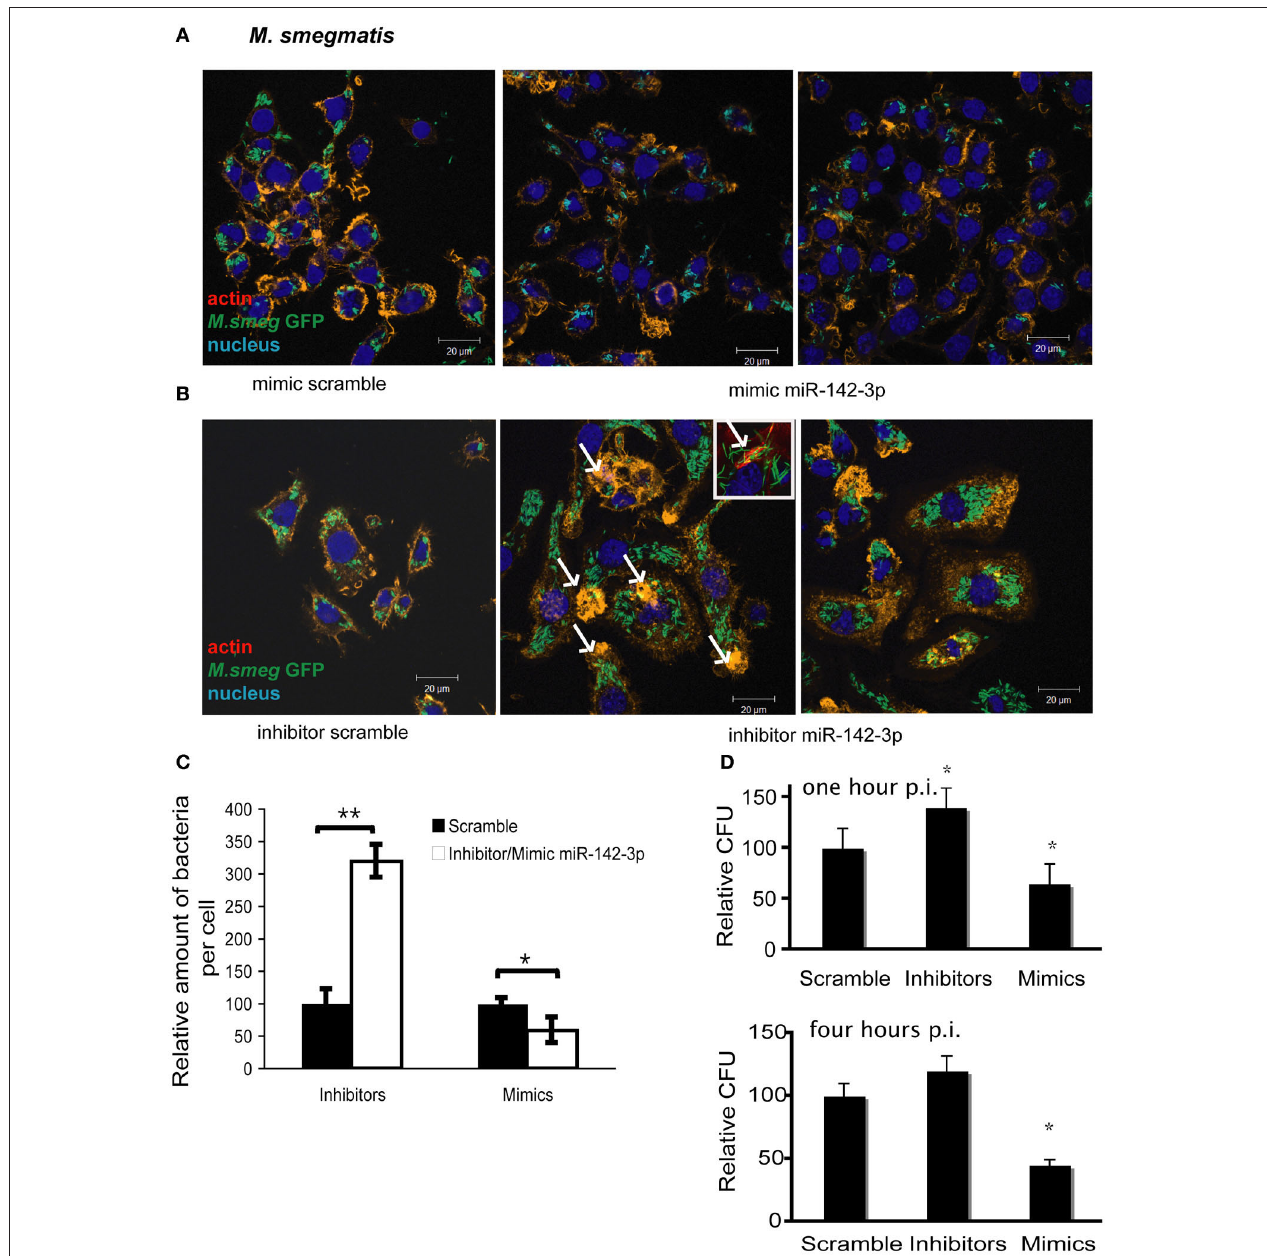
FIGURE 3 | miR-142-3p activity correlates with a reduction of the amount of internalized M. smegmatis per M ϕ . Confocal microscopy showing quantitative and qualitative analysis of J774A.1 macrophages treated with miR-142-3p mimics (A) or miR-142-3p inhibitors (B) , and challenged with M. smegmatis (MOI 10) for 4h. Arrows indicate phagocytic cups. Blue (DAPI), green ( M. smegmatis GFP), and light red/orange (Rhodamine-Phalloidin). Bar: 20 μ m. (C) Quantification of the relative amount of bacteria per macrophage